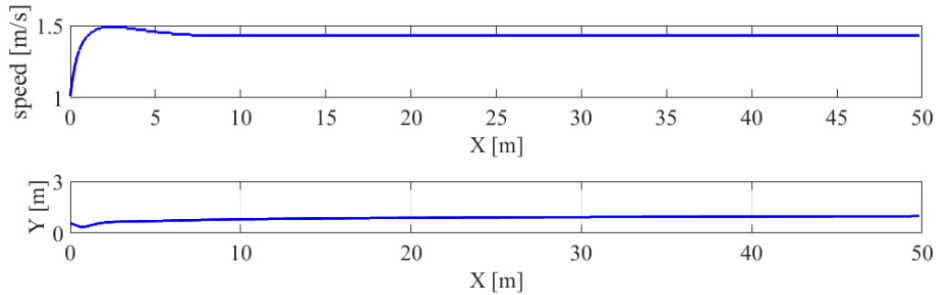
Figure 6. The walking speed (figure above) and trajectory (figure below) of a random pedestrian who arrives at 4.14 s and stops walking at 37.32 s when the simulation ends.